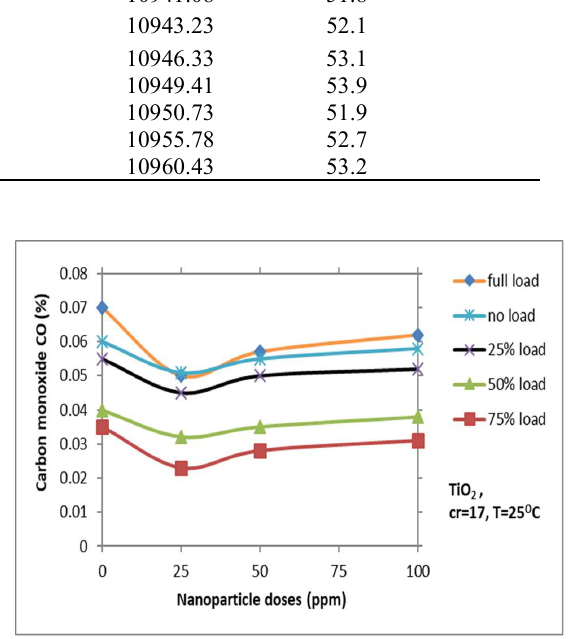
Fig. 3. variation of the carbon monoxide with Titanium nanoparticles